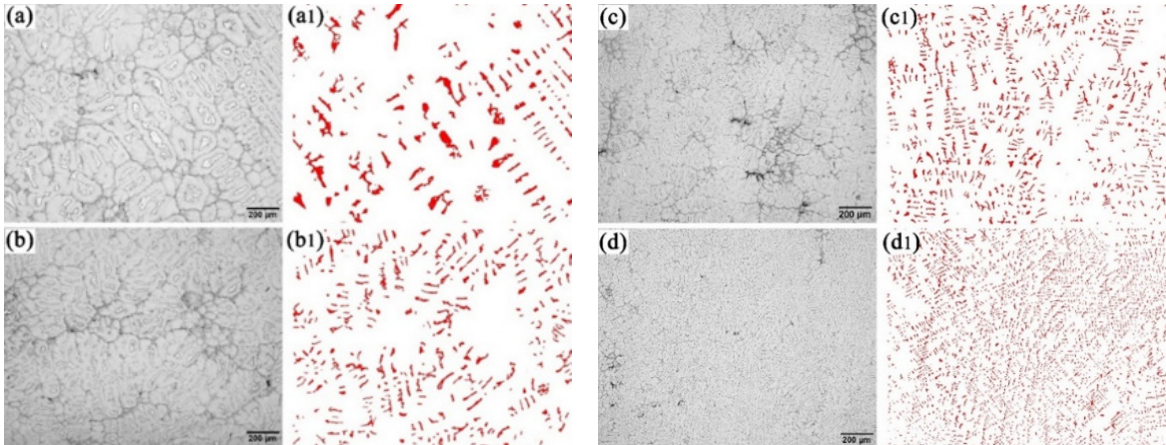
Microstructure at the center of the ingot with different diameters is given in Figure 6.